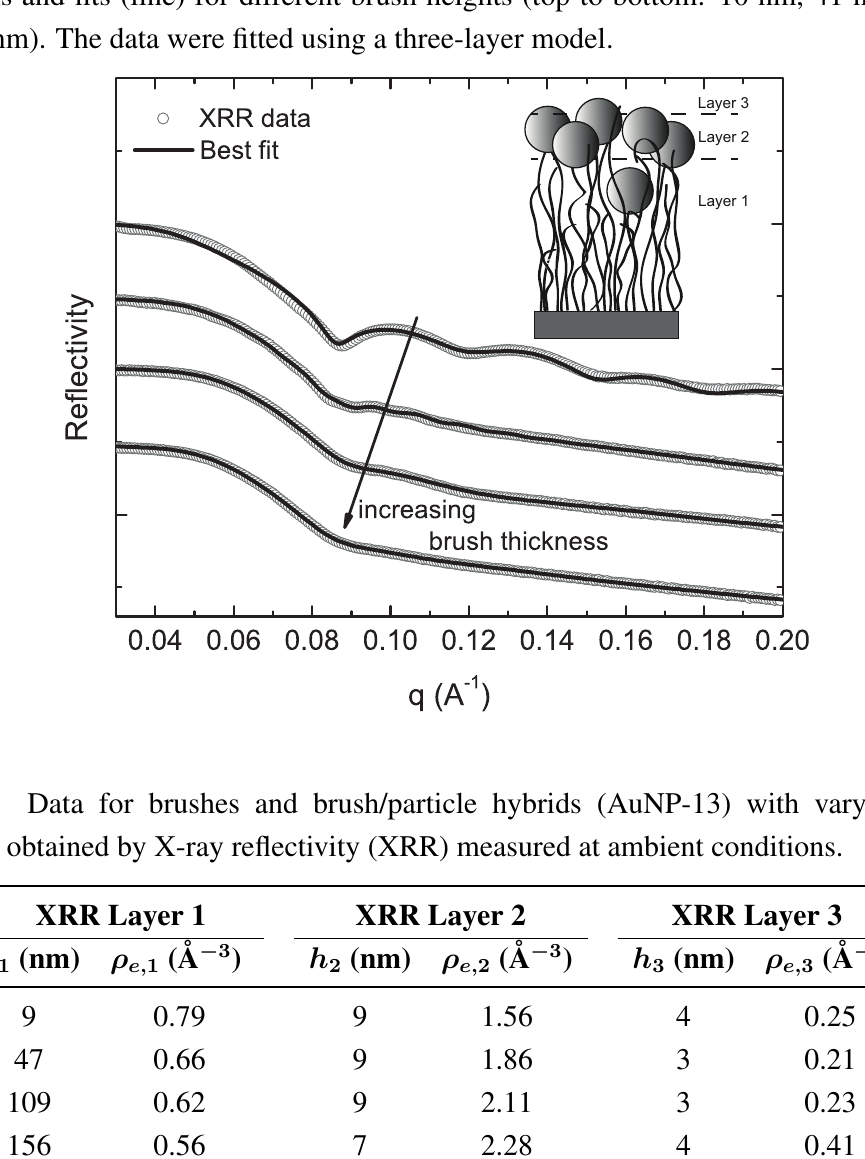
Figure 7. Experimental X-ray reflectivity (XRR) data (symbols) measured at ambient conditions and fits (line) for different brush heights (top to bottom: 10 nm, 41 nm, 94 nm and 128 nm). The data were fitted using a three-layer model.